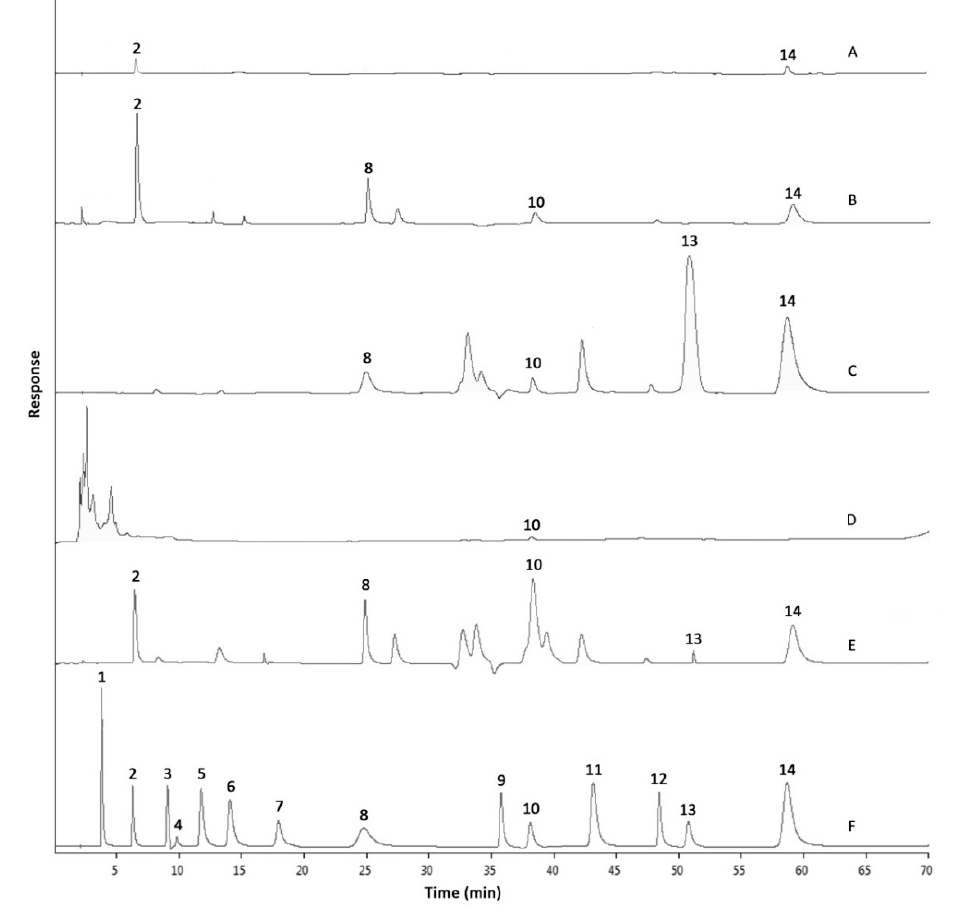
Figure 1. Representative HPLC chromatograms. A: AQF; B: BUF; C: EAF; D: HXF; E: RME; F: mixed phenolic standard. Peaks: 1, gallic acid; 2, protocatechuic acid; 3, p -hydroxybenzoic acid; 4, gentisic acid; 5, chlorogenic acid; 6, vanillic acid; 7, caffeic acid; 8, syringic acid; 9, p -coumaric acid; 10, ferulic acid; 11, sinapic acid; 12, salicylic acid; 13, curculigoside; 14, cinnamic acid.